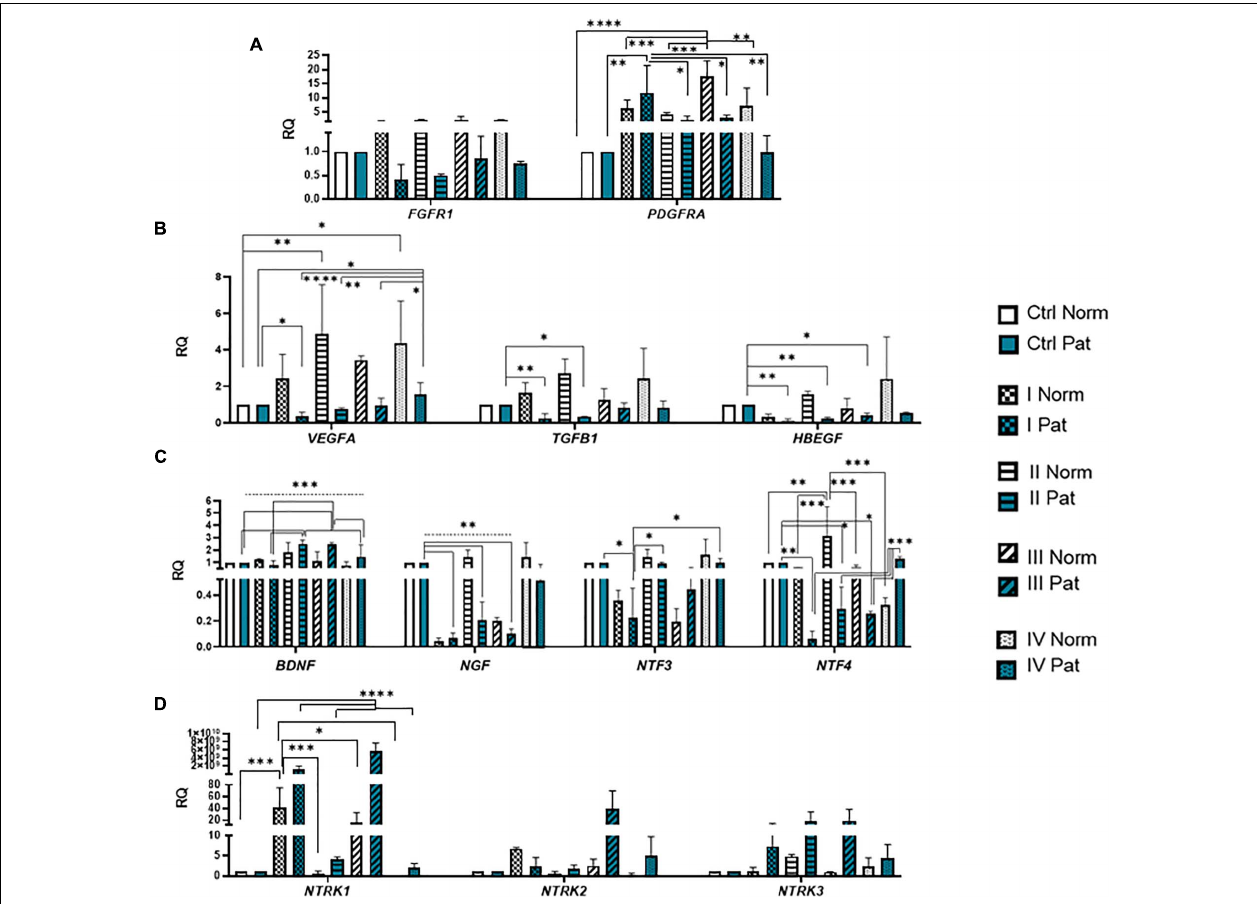
FIGURE 7 | Gene expression profile of growth and neurotrophic factors in hAFSCs from normal and fetus–affected gestations induced to neuronal differentiation. RT-qPCR analysis of (A) growth factor receptors FGFR1 and PDGFRA , (B) growth factors VEGFA, TGFB1 , and HBEGF , as well as (C) neurotrophic factors BDNF , NGF , NTF3 , and NTF4 and (D) their receptors NTRK1 , NTRK2 , and NTRK3 . Gene expression analysis was performed using control hAFSCs (not treated, Ctrl) and neuronal differentiation-induced hAFSCs (treated for 72 h with I–IV differentiation protocols; see Table 1 in section “Materials and Methods”) from normal (Norm, n = 3) and fetus-pathological (Pat, n = 3) gestations. RT-qPCR data are represented as relative fold change over undifferentiated control, normalized for the housekeeping genes GAPDH and RPL13A ; values are indicated as mean ± SD. *Denotes significant difference with p < 0.05, **denotes significant difference with p < 0.01, ***denotes significant difference with p < 0.005, and ****denotes significant difference with p < 0.0001, as evaluated using one-way ANOVA with Tukey’s post hoc